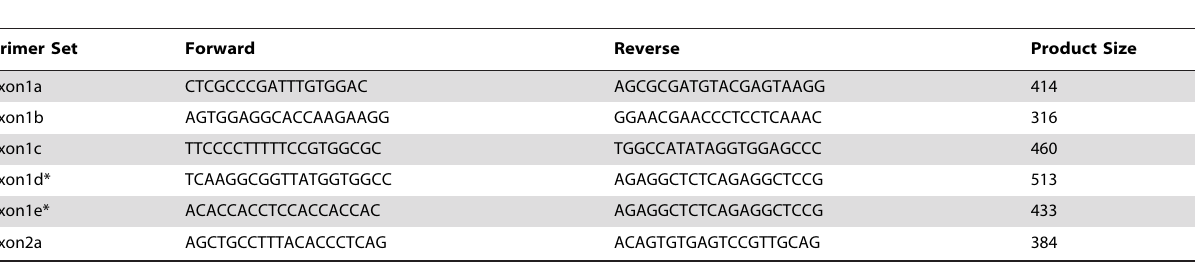
Primer sets Exon1a-1e were used to screen the first exon and flanking regions, primer set Exon2a was used to screen exon 2. * Primer set Exon1e replaced Exon1d for the screen of the MRC archive.